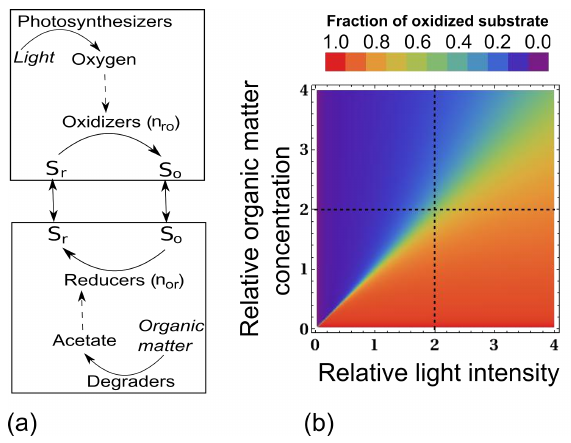
Figure 3. Redox regime shifts in a “complete ecosystem” model. (a) Illustration of the model. Oxidative and reductive processes take place in separate spatial zones, linked by chemical diffusion. The model explicitly represents the population dynamics of microbial photosynthesizers, decomposers, reducers, and oxidizers, and the chemical dynamics of oxygen, s o , s r , and acetate. Light intensity and organic matter availability are treated as control parameters. The dynamical equations corresponding to the model are presented in Sect. S8, Eqs. (S45)–(S54); these are integrated numerically to find the steady-state solution. Parameter values are also listed in the Supplement. (b) Steady-state solution of the model illustrated in (a) , obtained numerically, plotted as a function of the control param- eters, light intensity (relative to the typical value 10µE s − 1 m − 2 ; Huisman et al., 2006) and organic matter concentration (relative to the typical value 100mgcm − 3 ; Allison et al., 2010). The color rep- resents the global redox state (see color key). The model shows re- dox regime shifts as the organic matter concentration is varied at fixed light intensity (vertical dashed line) or as the light intensity is varied at fixed organic matter concentration (horizontal dashed